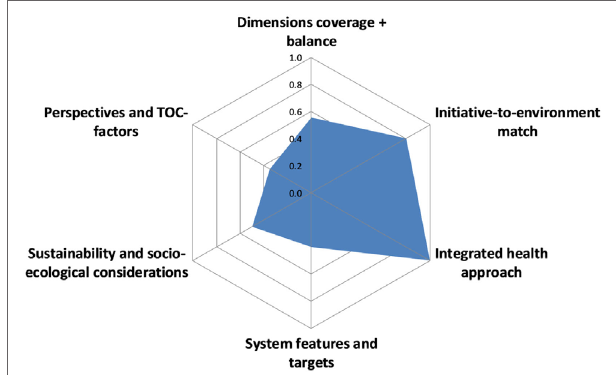
FigUre 6 | Assessment of One Health thinking in the Southern African Centre for Infectious Disease